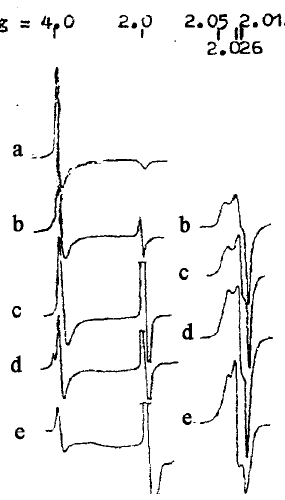
Figure 7. EPR spectra of high-spin ( left side ) or low-spin ( right side ) Fe 2+ nitrosyl iron complexes with ethylene diamine tetraacetate (EDTA) ( a ), citrate ( b ), ascorbate ( c ), phosphate ( d ) or water ( e ). The spectra were recorded at 77 K [76].